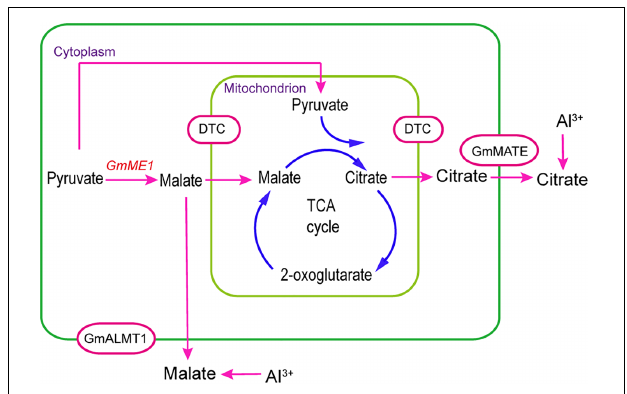
FIGURE 9 | A Model proposing the role of GmME1 in the process of Al-induced malate and citrate efflux from soybean roots. Cytosolic malic enzyme, GmME1, was supposed to increase malate synthesis in cytosol and thus supply malate to the TCA cycle as an anaplerotic reaction to promote citrate pool over citrate exudation under Al stress. Imported malate and exported citrate through mitochondrial membrane were supposed to occur by GmDTC. The malate and citrate efflux across plasma membrane might have occurred by GmALMT1 and MATE family proteins (GmFRDL and GmAACT1),